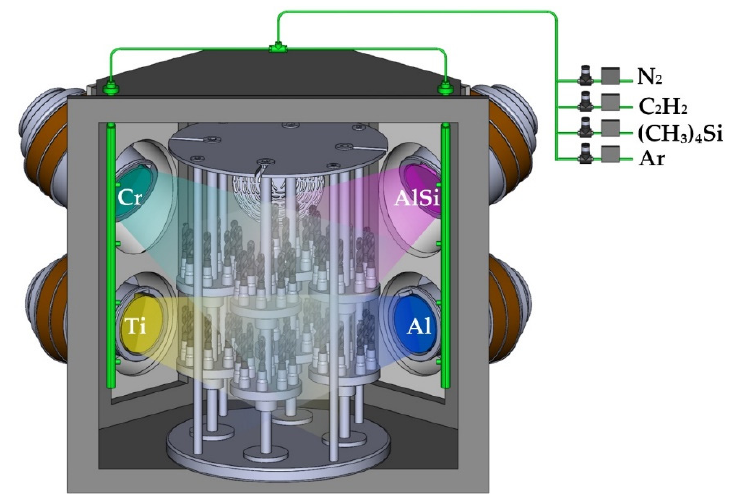
Figure 2. Schematic diagram of a hybrid vacuum-plasma installation for vacuum arc and gas-phase coatings’ deposition.